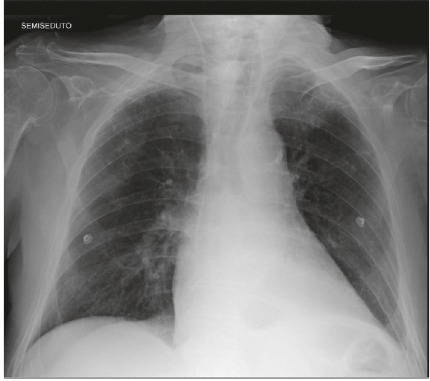
Figure 4: Chest radiography two months